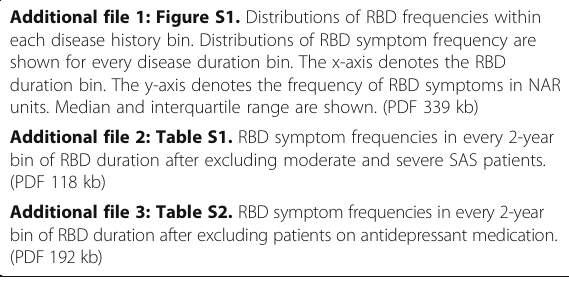
Additional file 1: Figure S1. Distributions of RBD frequencies within each disease history bin. Distributions of RBD symptom frequency are shown for every disease duration bin. The x-axis denotes the RBD duration bin. The y-axis denotes the frequency of RBD symptoms in NAR units. Median and interquartile range are shown. (PDF 339 kb)